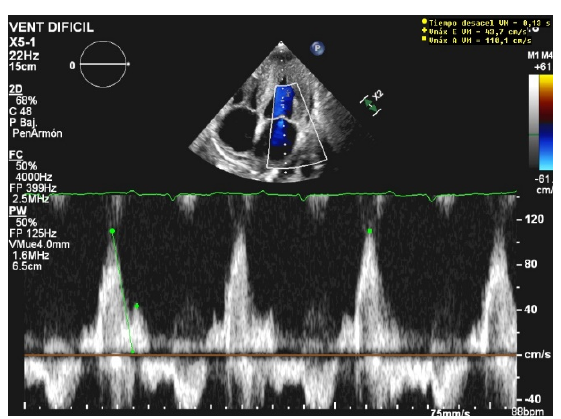
Figure 1. E wave height, deceleration time, and A wave. Normal filling pattern.